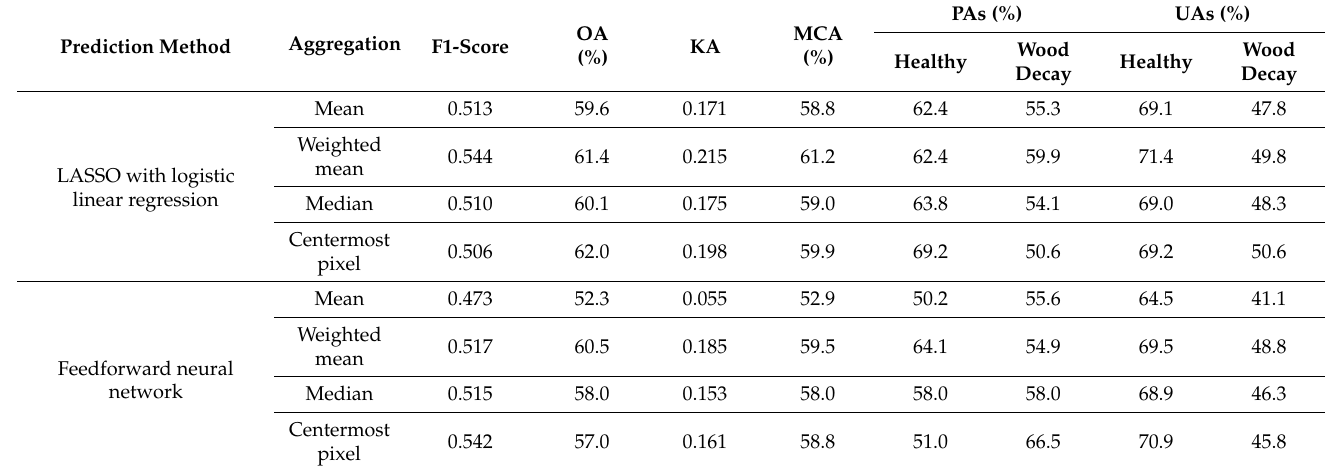
Table 5. Overall summary of the model performances with pixel aggregations for Dataset